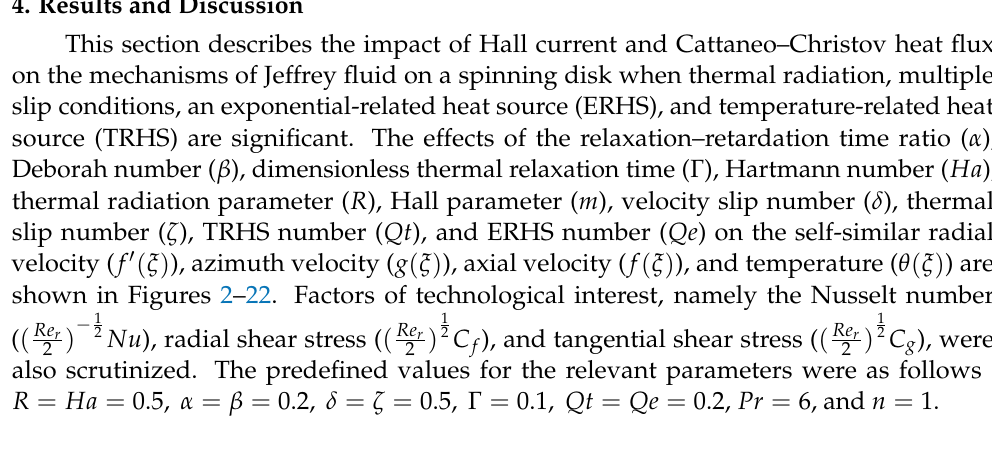
Table 1. Comparison of ( Re r Hayat et al. [44], where R = m = δ = ζ = Γ = Qt = Qe = 0, α = 1, and β = 0.25. Ha